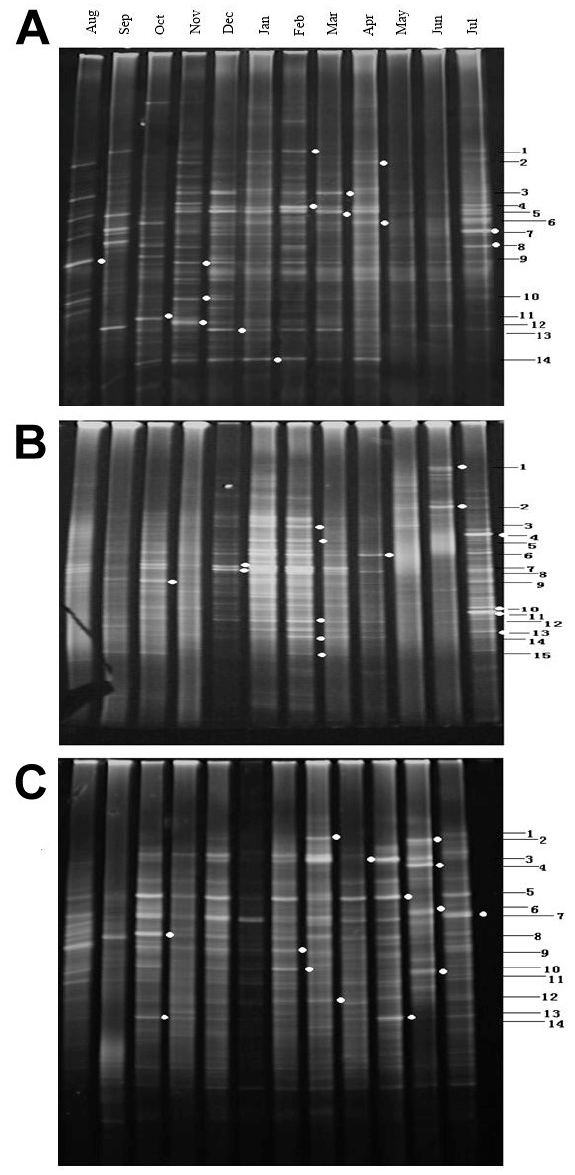
Figure 4. Denaturing gradient gel electrophoresis (DGGE) fingerprints of the samples from three reservoirs. Dots show the bands that were analyzed by sequencing. ( A ) Xi-keng Reservoir; ( B ) Shi-yan Reservoir; ( C ) Luo-tian Reservoir.